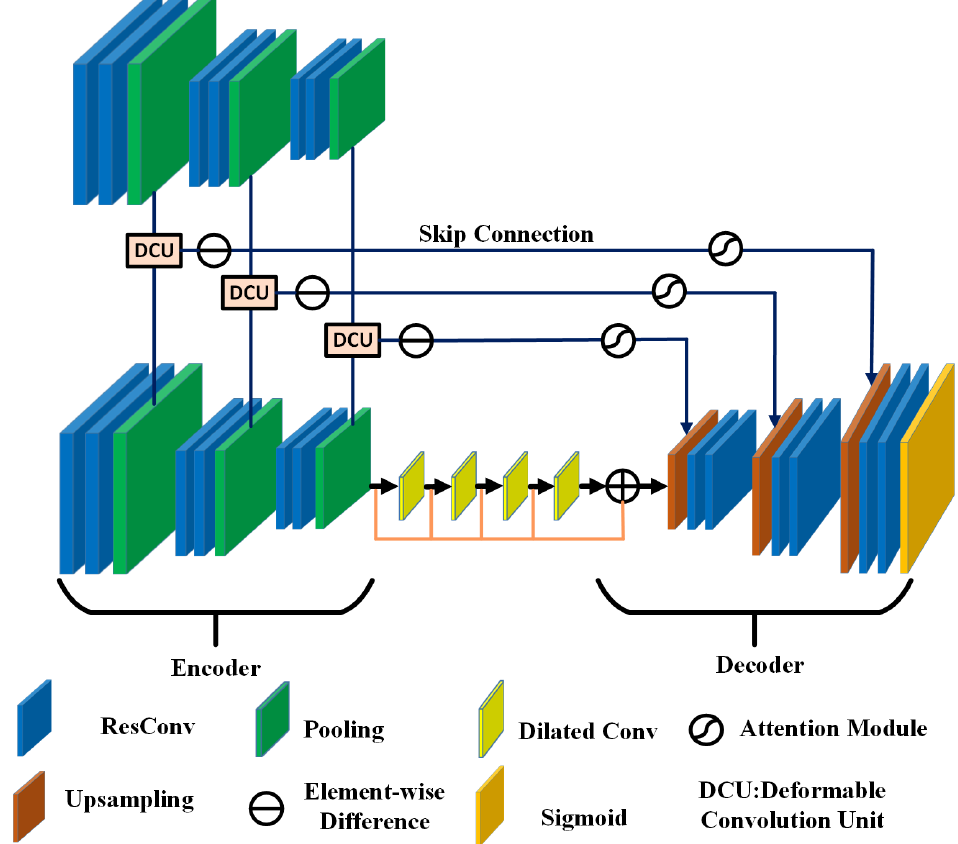
Figure 4. Architecture of the alignment-aware CD